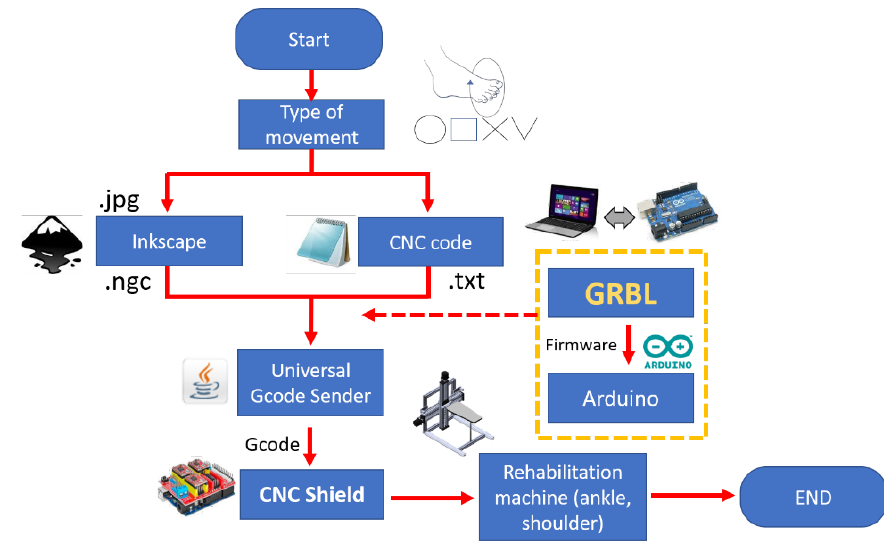
Figure 12. Procedure to implement a routine in the rehabilitation machine.